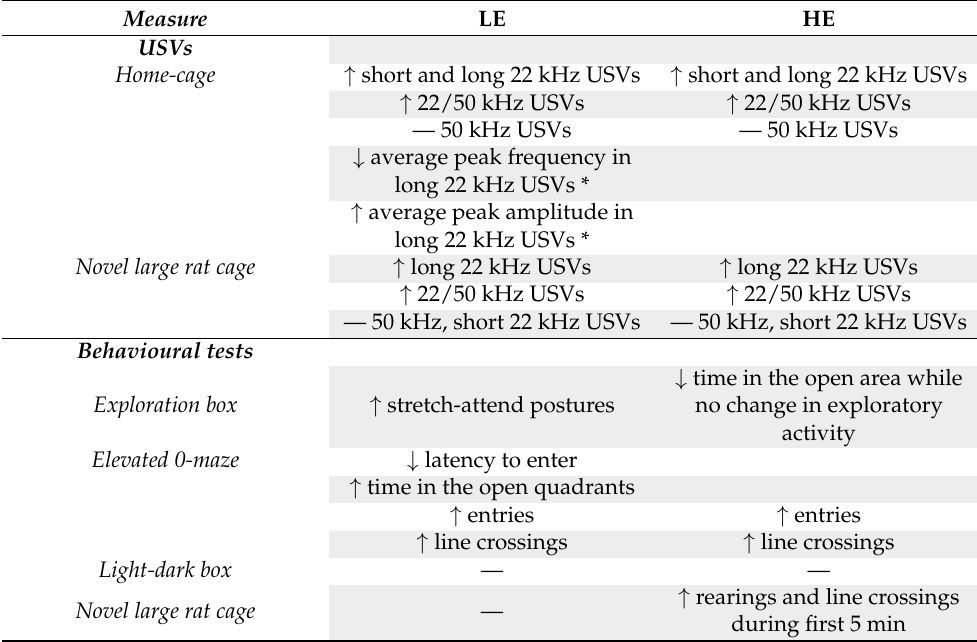
Table 1. Overview of the effects of NPS (1 nmol, i.c.v.) on ultrasonic vocalizations and behaviour depending on the exploration